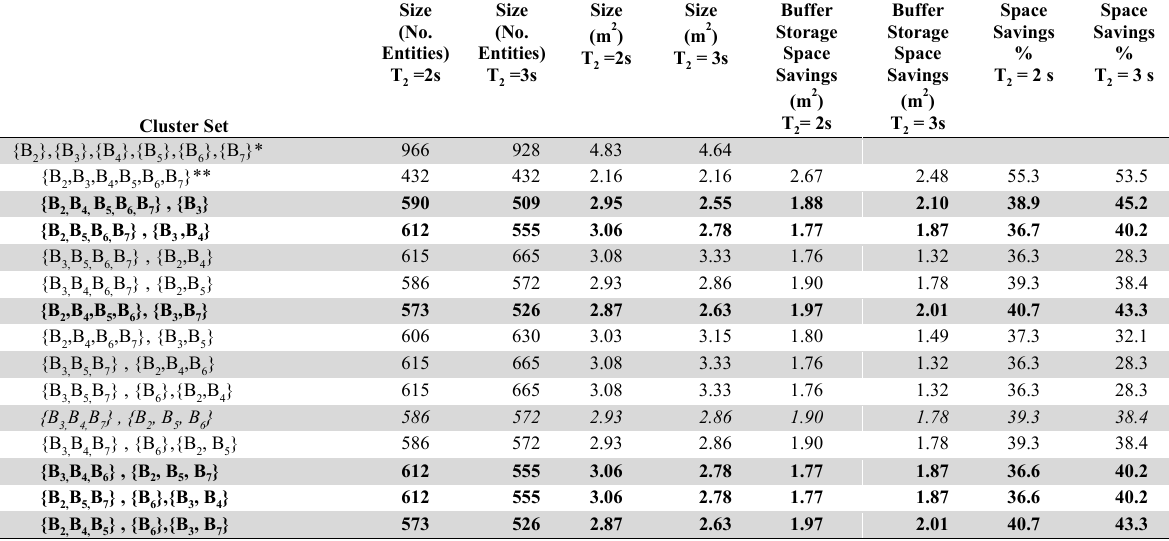
Table 5 Buffer cluster sets and buffer storage savings with T 2 at 2 and 3 seconds